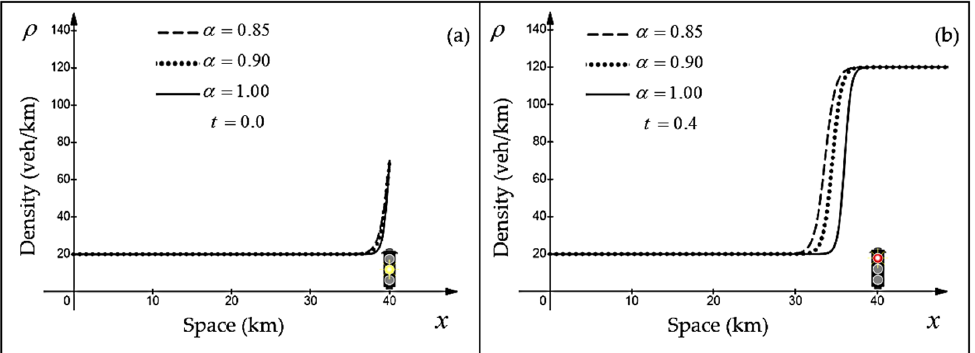
Figure 3. The density profiles of the solution of Equation (30) in the ρ − x plane for various values of the fractional order: ( a ) The jamming formation as the yellow light is on at t = 0 h; ( b ) different moving jam waves at t = 0.02 h.